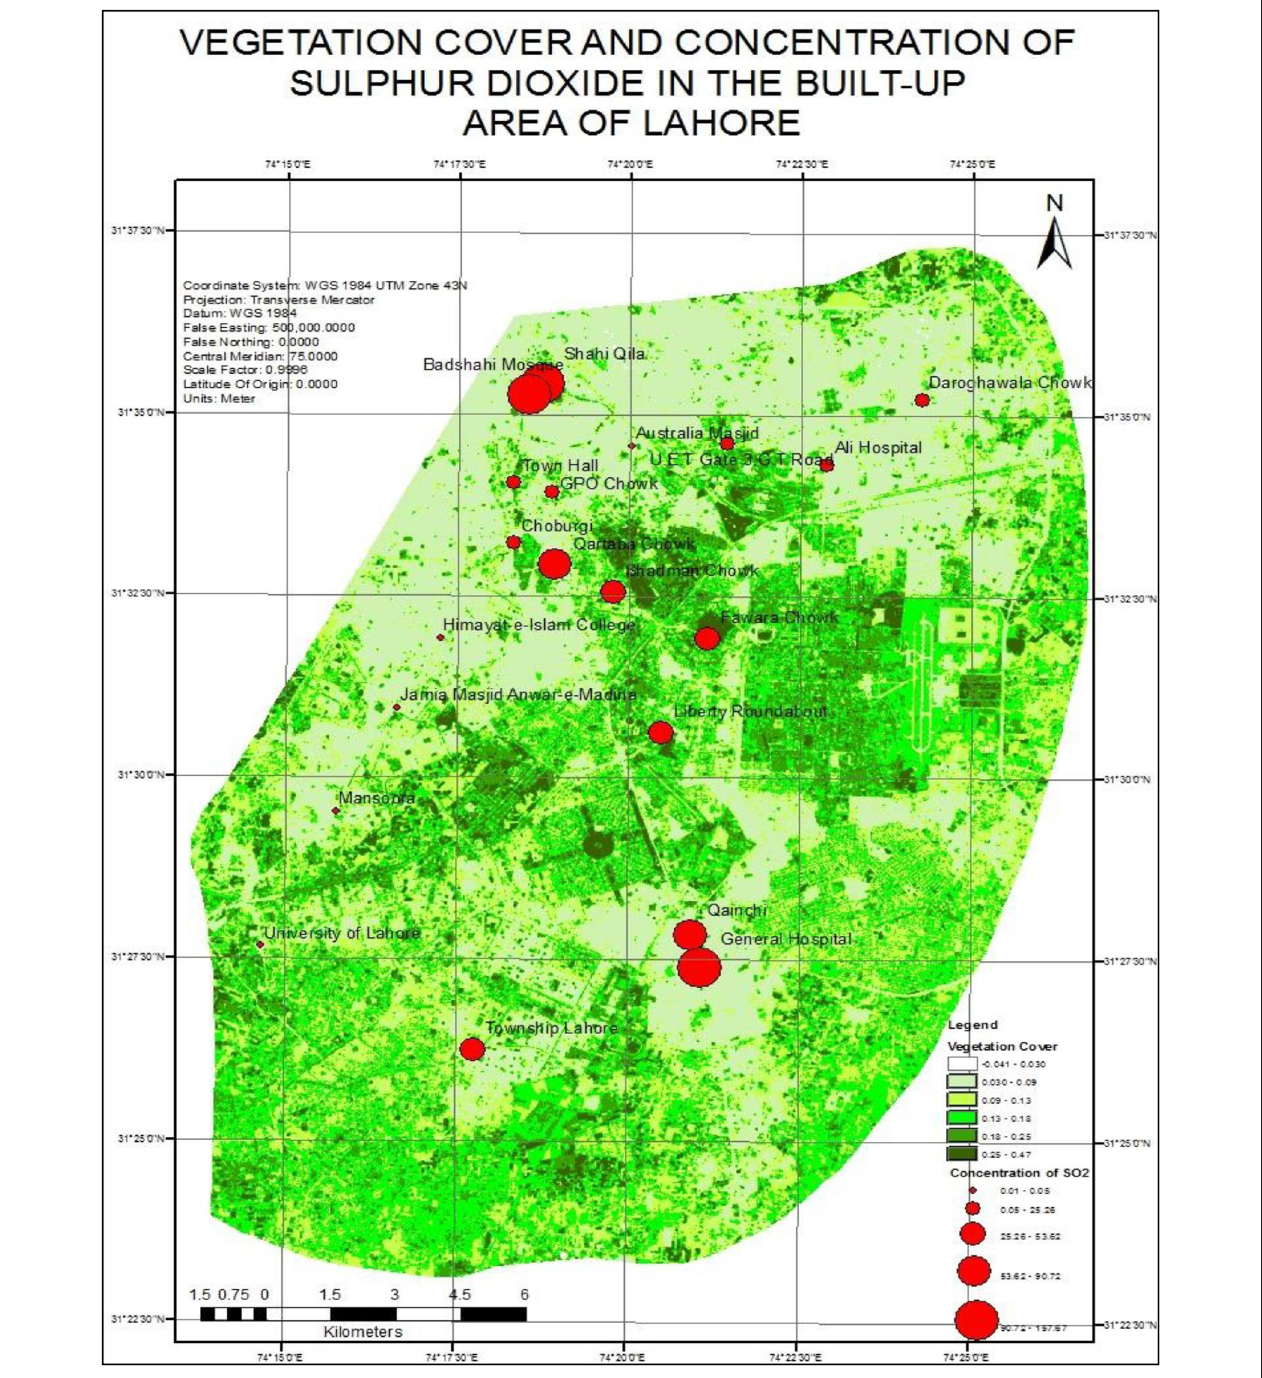
FIGURE 12 | Impact of vegetation and the concentration of sulfur dioxide.